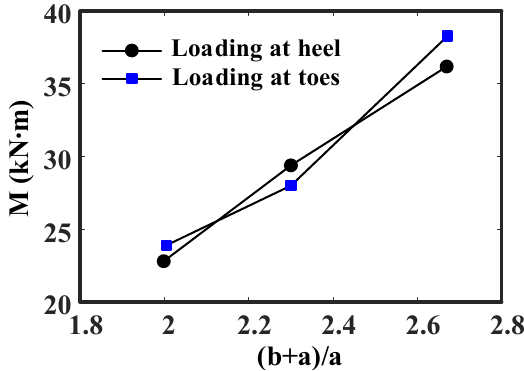
Figure 15. Measured ultimate bending moment (M u − exp ) versus b/a